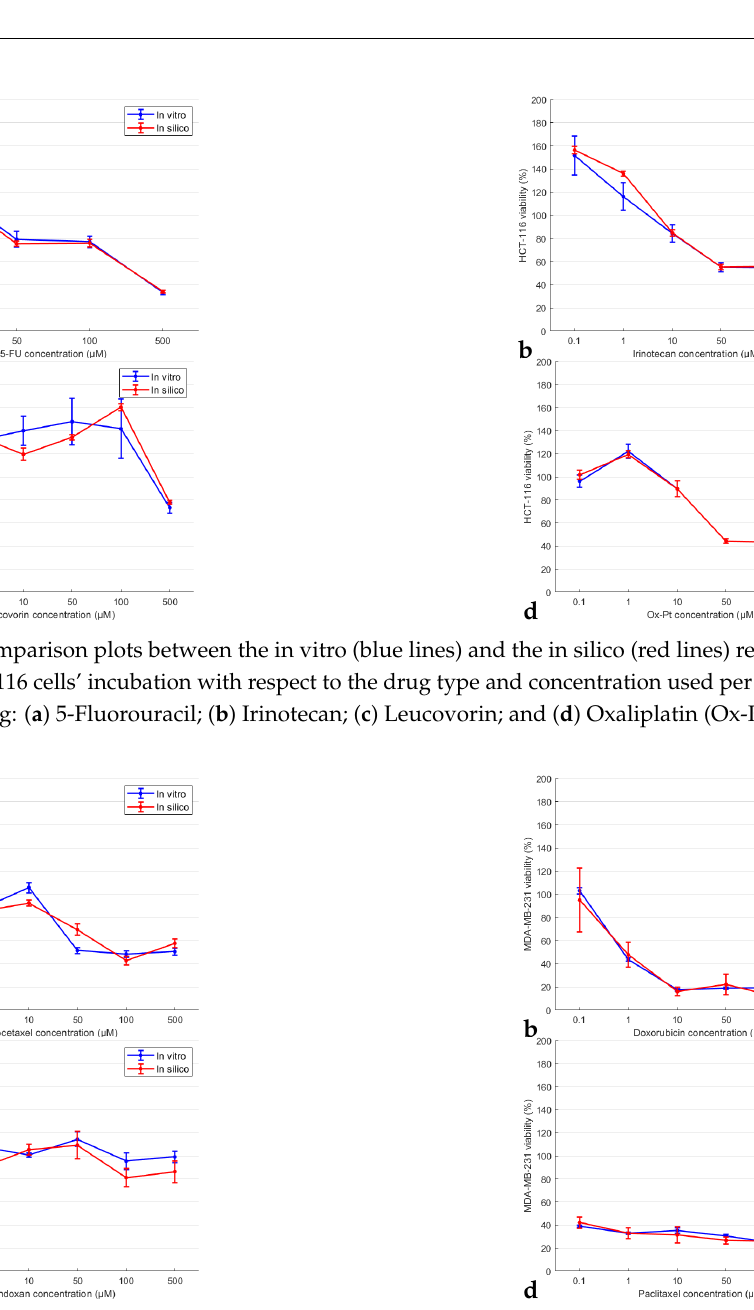
Figure 4. Comparison plots between the in vitro (blue lines) and the in silico (red lines) results after 72 h of MDA-MB-231 cells’ incubation with respect to the drug type and concentration used per treatment scenario, drug: ( a ) Docetaxel; ( b ) Doxorubicin; ( c ) Endoxan; and ( d )